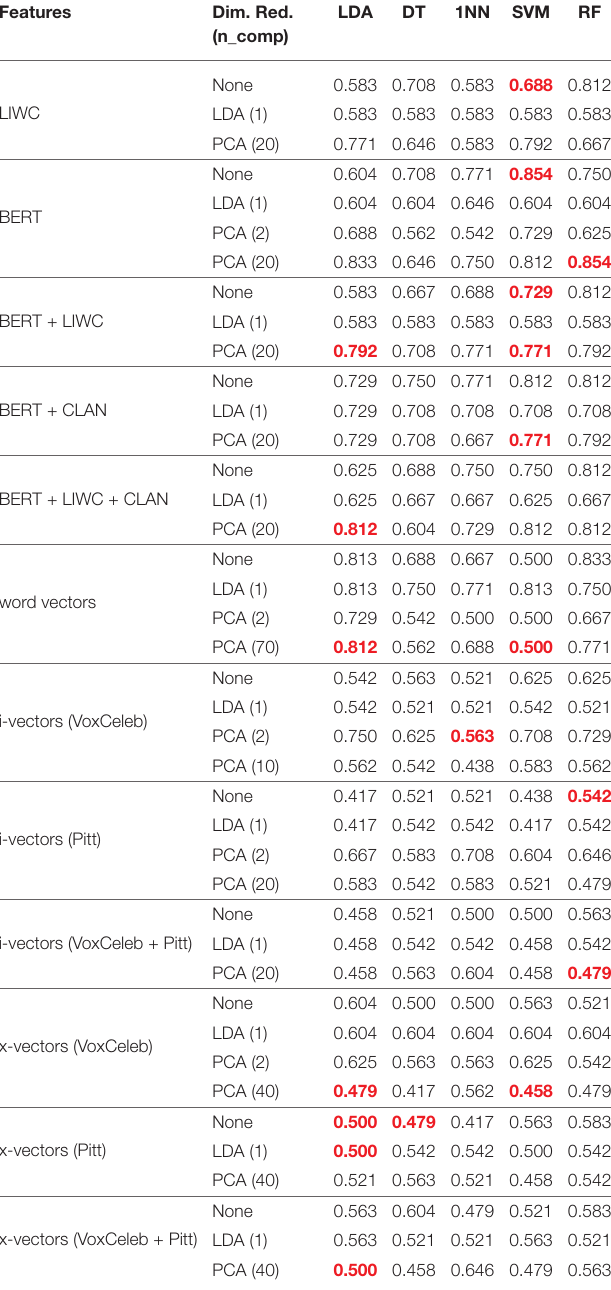
TABLE 3 | LOSO accuracies for each of the classifiers. The best-performing models for each feature type are red. Features